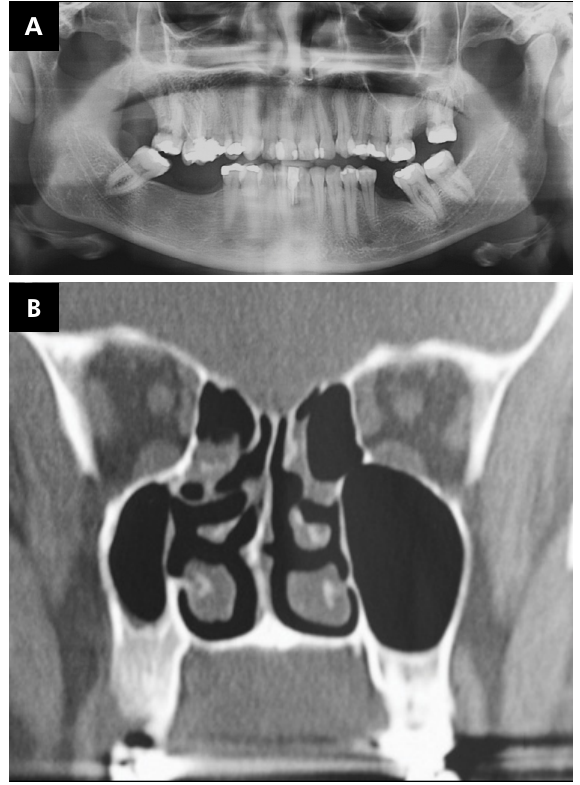
Figure 2. (A-C) Sinus hypoplasia observed in both panoramic x-ray and CT. The CT was crucial for the diagnosis.